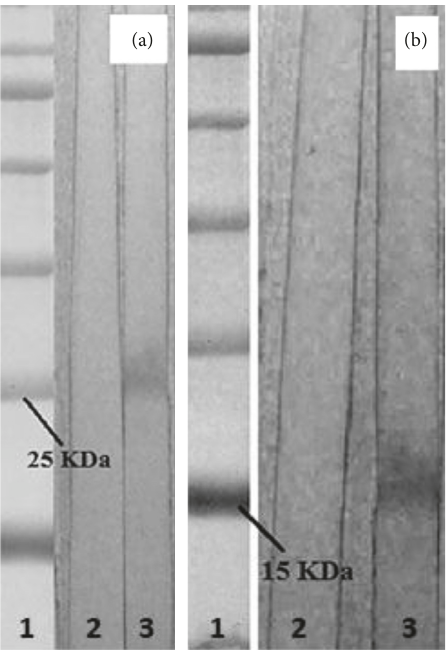
Figure 1: Binding capability evaluation of α -OmpW and α -CtxB